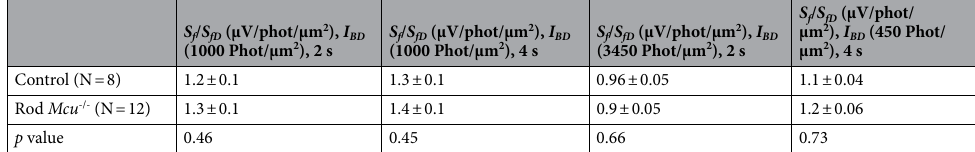
Table 2. Normalized sensitivity at 2 s and 4 s time points after turning off the background light step. S f /S fD normalized fractional sensitivity, I B D intensity of the background illumination.